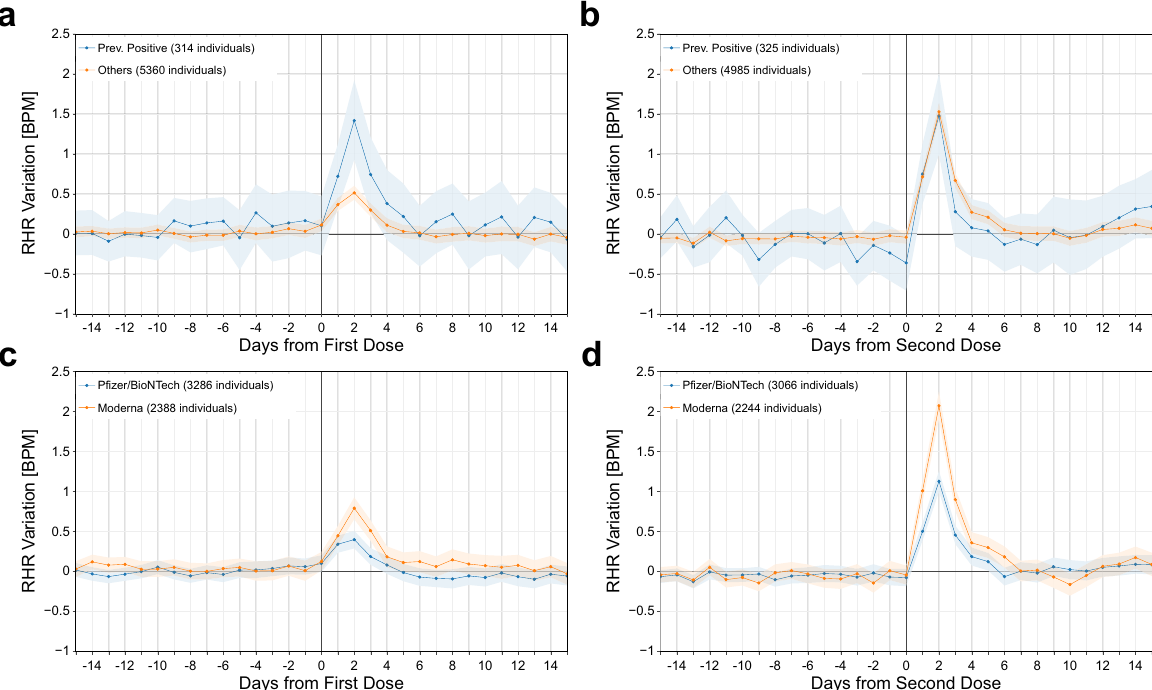
Fig. 3 Resting heart rate changes by previous COVID-19 infection and vaccine received. Mean and 95% con fi dence interval of the absolute individual changes in resting heart rate (in BPM) with respect to the individual baseline around the date of vaccination (day 0), for the fi rst dose of the vaccine ( a ), ( c ), and for the second dose ( b ), ( d ), based on prior COVID-19 infection ( a ), ( b ), and based on the type of mRNA vaccine received, either P fi zer-BioNTech or Moderna vaccines ( c ), ( d